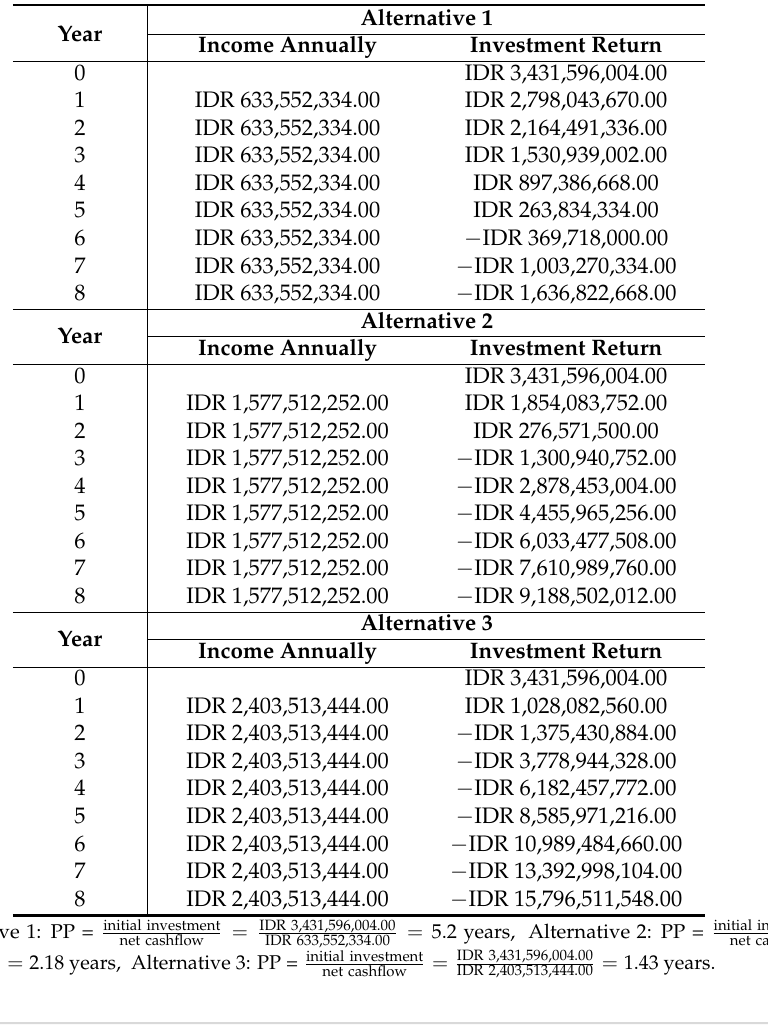
Table 11. Payback Period.